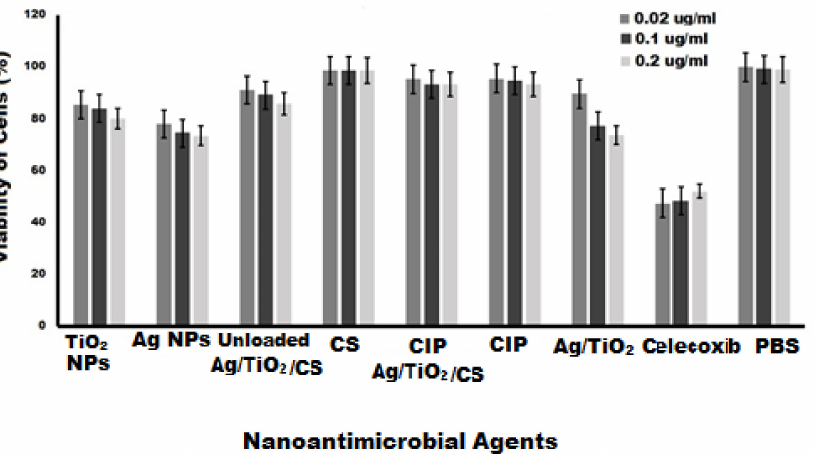
Figure 10. Cytotoxicity analysis of nanoformulations at various concentrations for 24 h of incubation, Celecoxib (PC) and PBS (NC) of study.